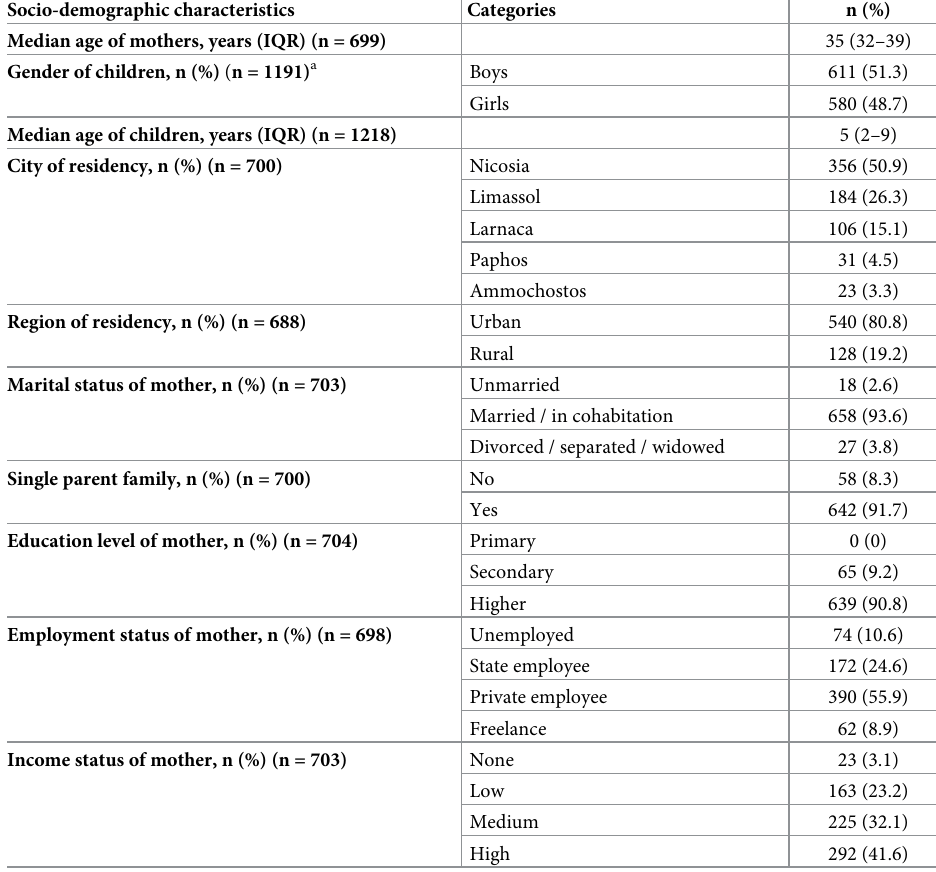
Table 1. Socio-demographic characteristics of the mothers and their children (n = 703). Socio-demographic